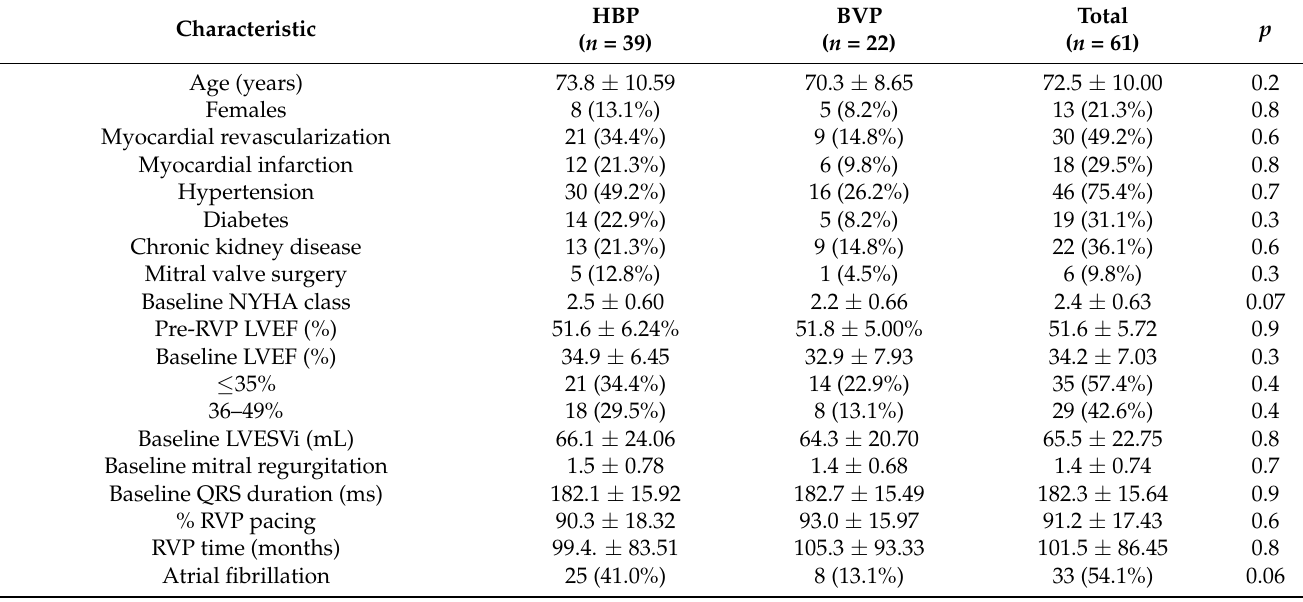
Table 1. Baseline characteristics.